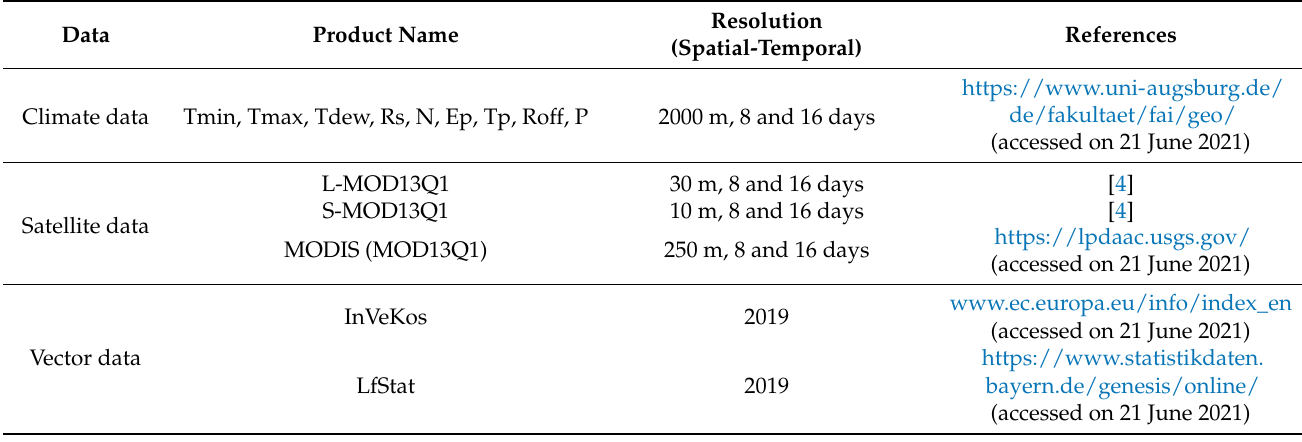
Table 1. A summary of the collected datasets for crop modelling of winter wheat (WW) and oil seed rape (OSR) in 2019. The satellite data used for crop yield modelling are synthetic L-MOD13Q1, S-MOD13Q1, and real Moderate Resolution Imaging Spectroradiometer (MODIS) MOD13Q1. The climate parameters are minimum temperature ( ◦ C) (Tmin), maximum temperature ( ◦ C)